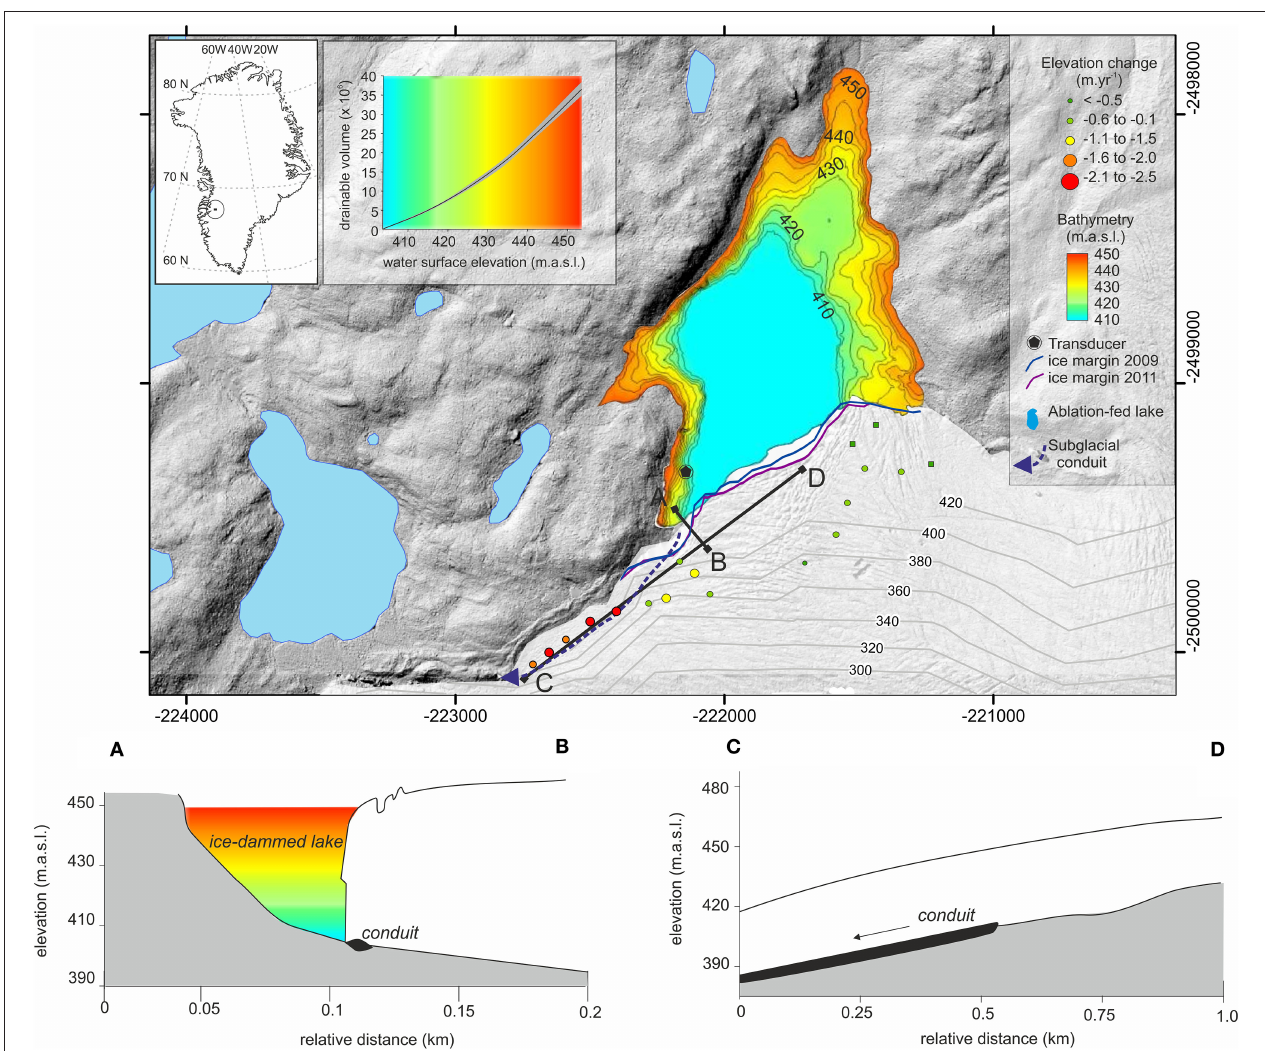
FIGURE 1 | Study site location, topography and detail of conduit geometry. Circles denote rates of change in elevation as calculated between August 2011 DEM and field surveyed points in May 2015. Profiles of ice surface and subglacial bed elevation are depicted along transects (A,B) and transects (C,D) , as indicated on map. Contours on ice are bed elevation. Map grid coordinates are UTM